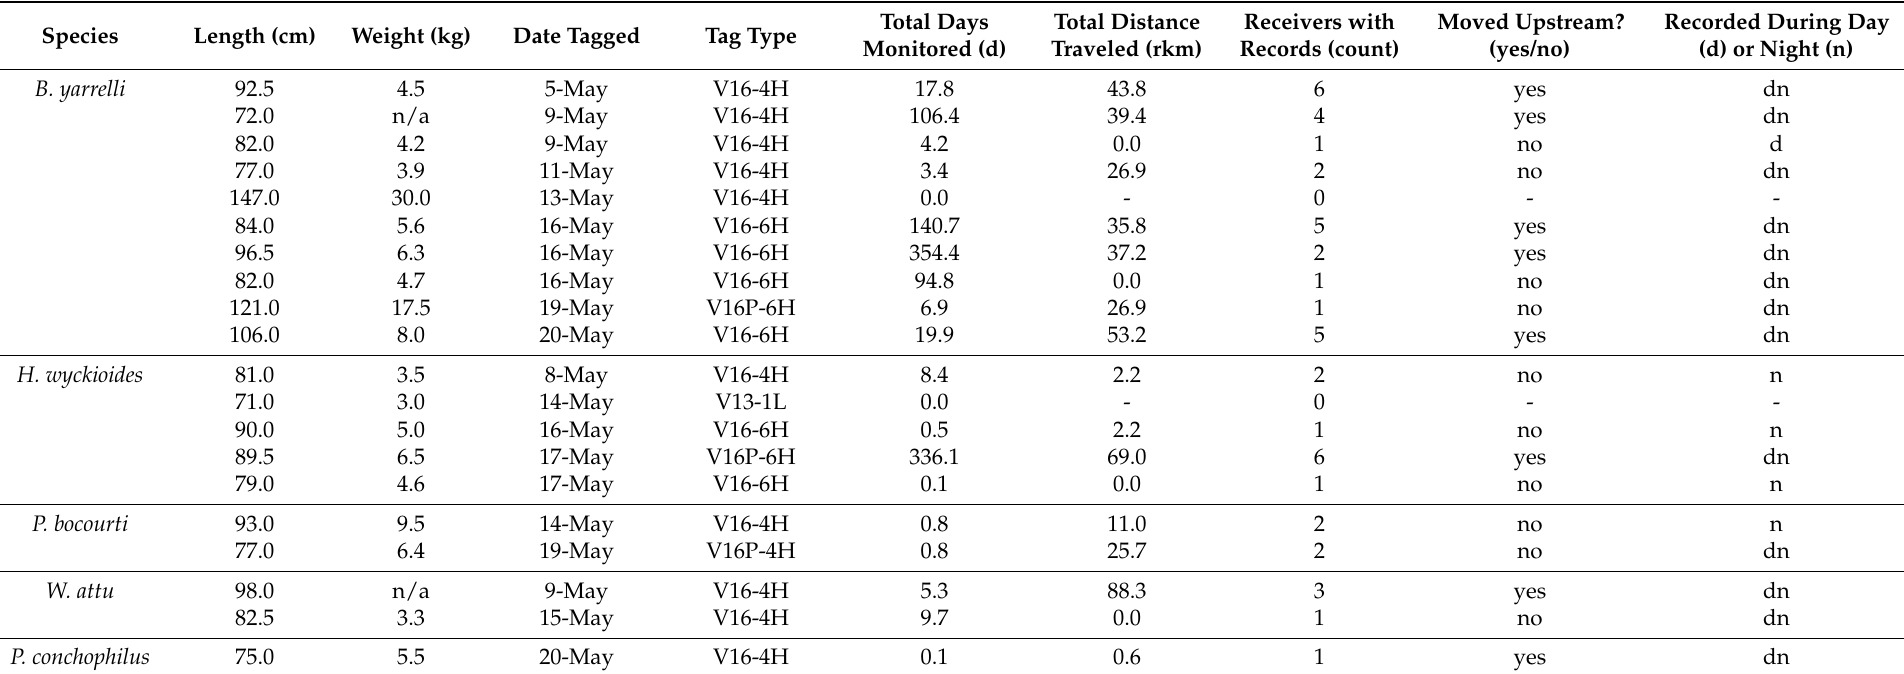
Table 3. Movement characteristics of wild catfishes monitored in the Mekong River, northern Thailand and Lao PDR from May 2006 to May 2007. “Total days monitored” is the number of days between the release time and the last time the fish was detected by the receiver array; this was zero if a fish was never detected by a receiver. “Total distance traveled” was zero if a fish was released nearby a receiver and was only detected by that